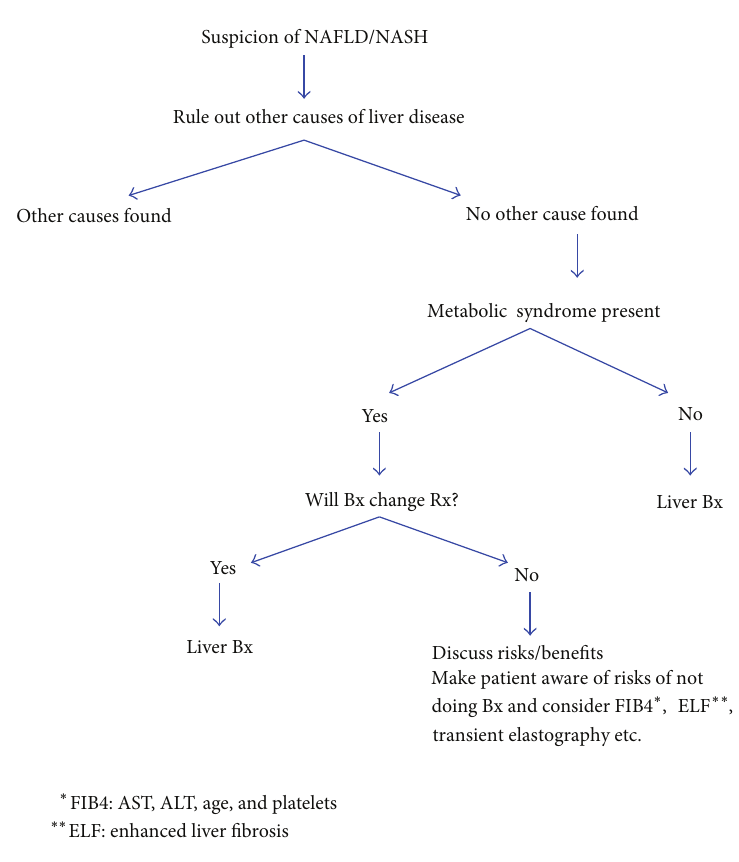
Figure 2: Diagnostic approaches to the patient suspected of having NAFLD/NASH